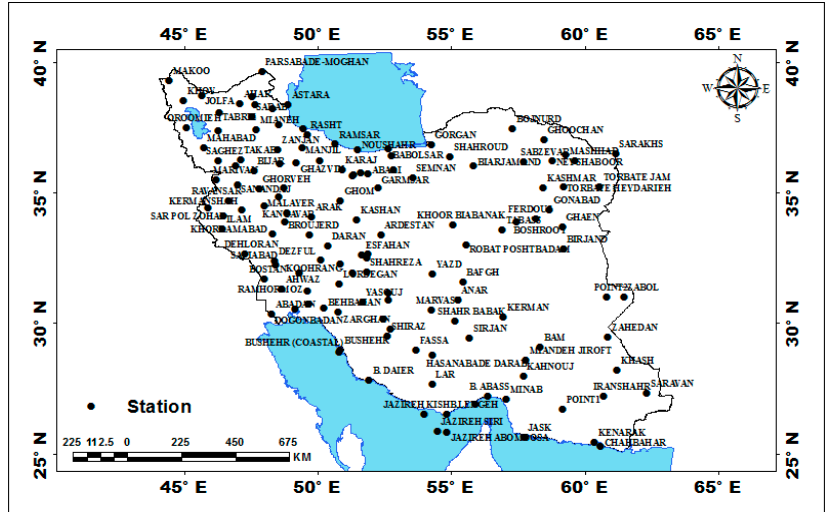
Figure 1. Distribution of Stations.